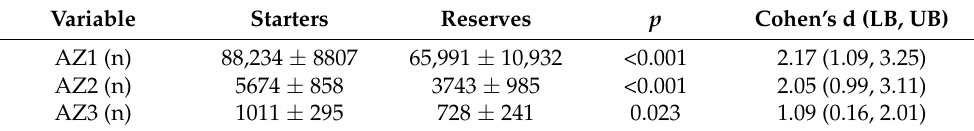
Table 1. Cont. Variable Starters Reserves